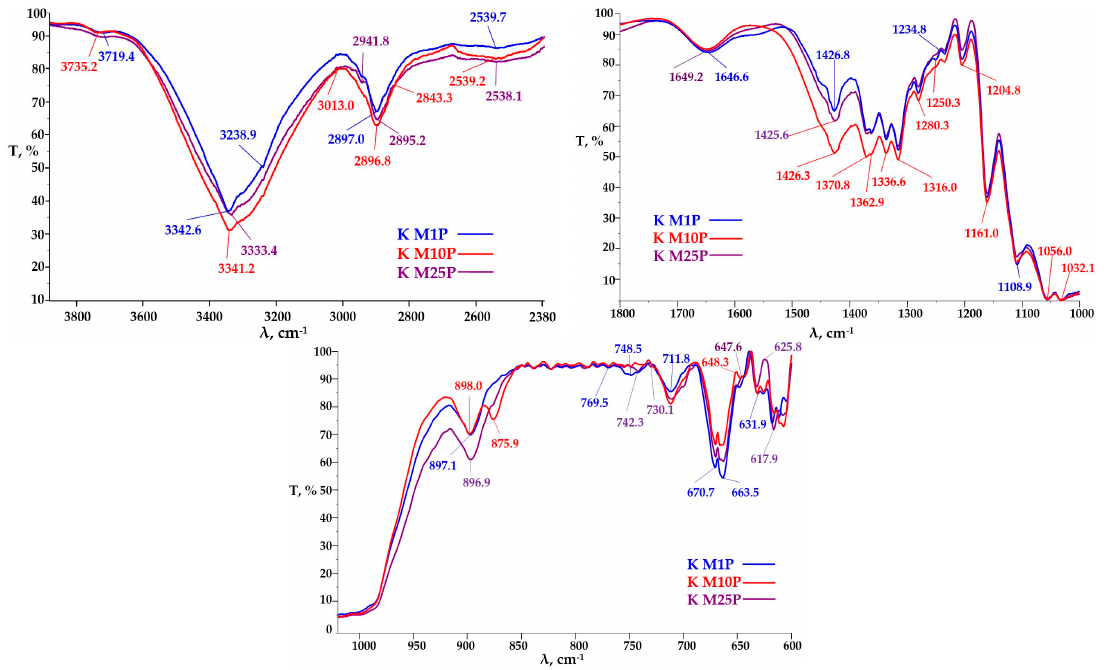
Figure 8. FTIR spectra of KM after different number of passes through microfluidizer.